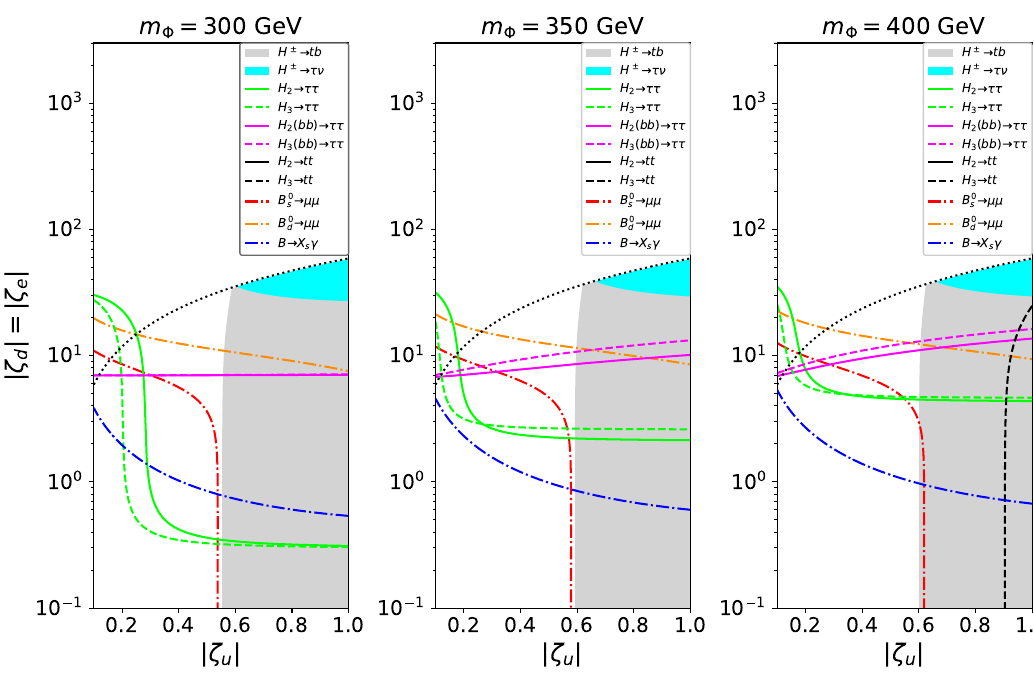
= 0 . 8 , θ = − 0 . 9 , θ = θ = − 2 . 7 , θ = θ + 0 . 04 , 7 7 u d e u are degenerated: m = 300 GeV (left), m = 350 GeV (middle), Φ Φ Φ , ( H ) and H ( bb ) → ττ , 2 → ττ 3 → ττ 2 can be seen as the 3 → tt